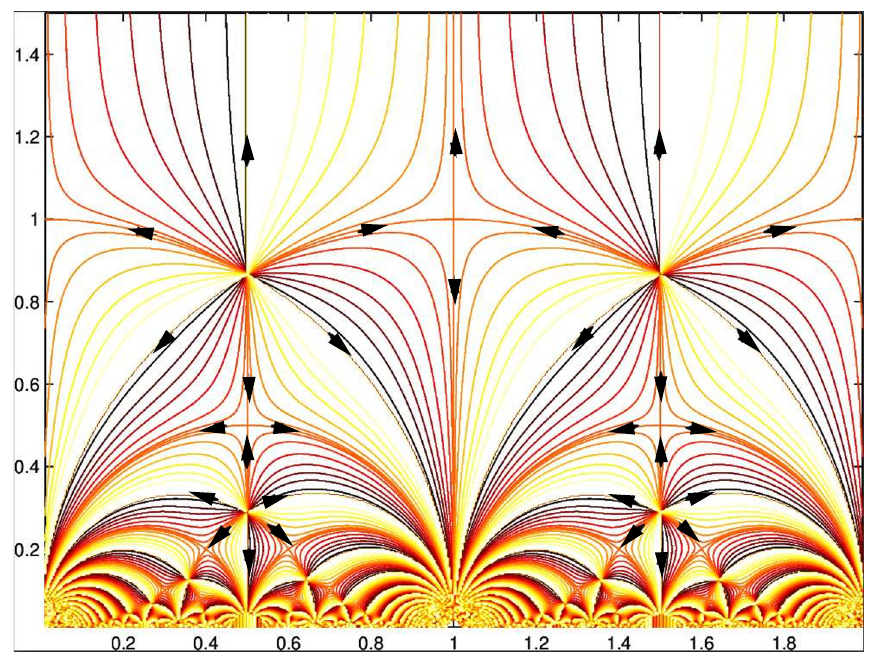
Figure 3 . Temperature flow of the conductivity on the event horizon for Γ(1) symmetry, assuming it is generated by varying | J | , keeping arg( J ) fixed. The diagram is obtained simply by plotting lines of constant arg( J ) , which are represented by different colours from red ( Ψ = 0 ) through black ( Ψ = π ) to